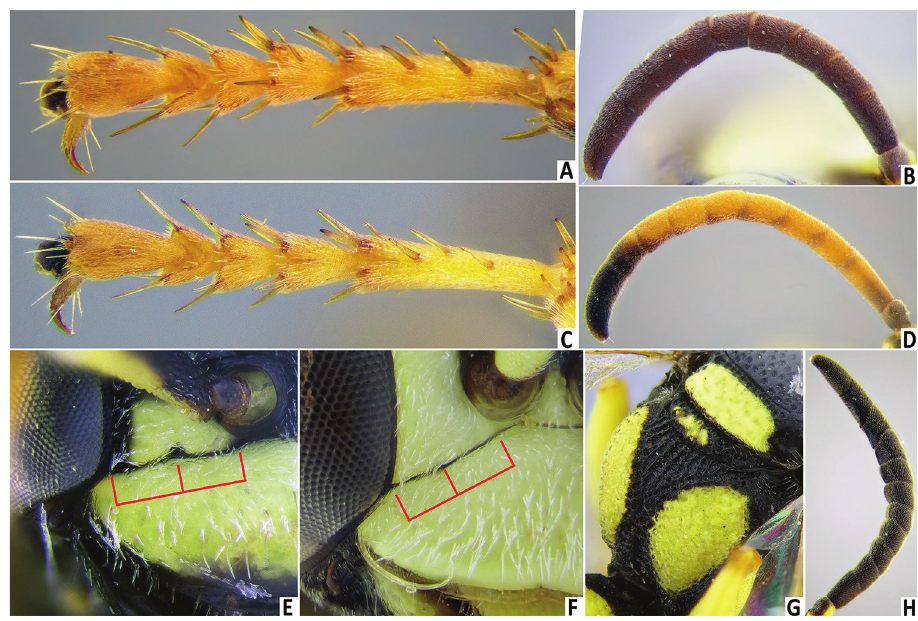
Figure 7. Hoplisoides leleji Mokrousov, sp. nov., holotype, female ( A–B ), and H. latifrons Spinola from Azerbaijan [MMPC] ( C–H ), female ( A–E, G ), male ( F, H ): A , C midtarsus, dorsal view B, D, H an- tenna, dorsal view E, F tentorial pit and adjacent area, frontal view G scutellum, metanotum and propo- deum, posterolateral